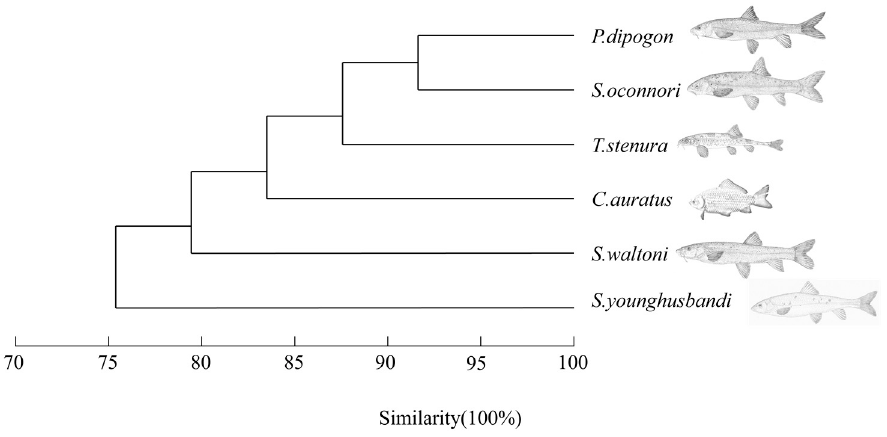
Figure 2. Cluster analysis of niche breadth of main fish caught.